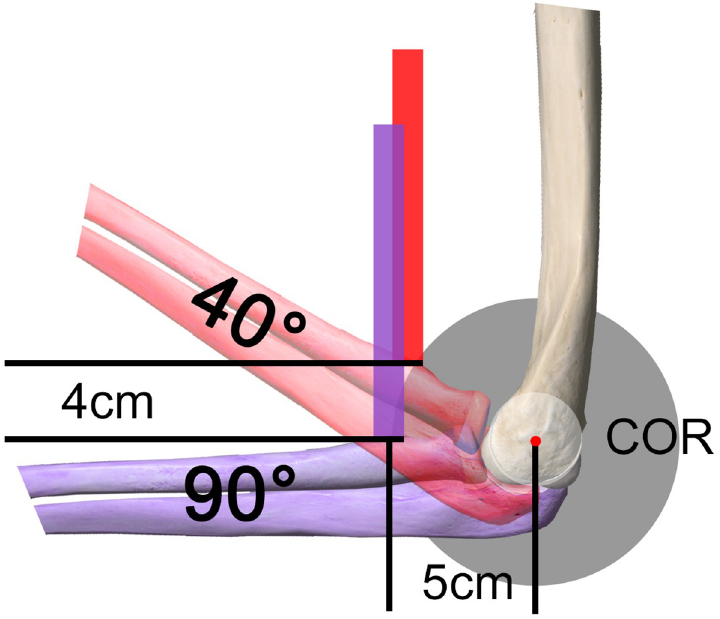
Fig 1. Influence of tendon length by graft fixation in 40˚ and 90˚. Considering that the radial tuberosity moves along a radius of 5cm relative to the center of rotation (COR) of the elbow, an allograft tendon refixation with same traction in 40˚ (red forearm) compared to 90˚ (violet forearm) of elbow flexion may lead to a shortening of 4cm, representing almost 60% of the original distal biceps tendon length.